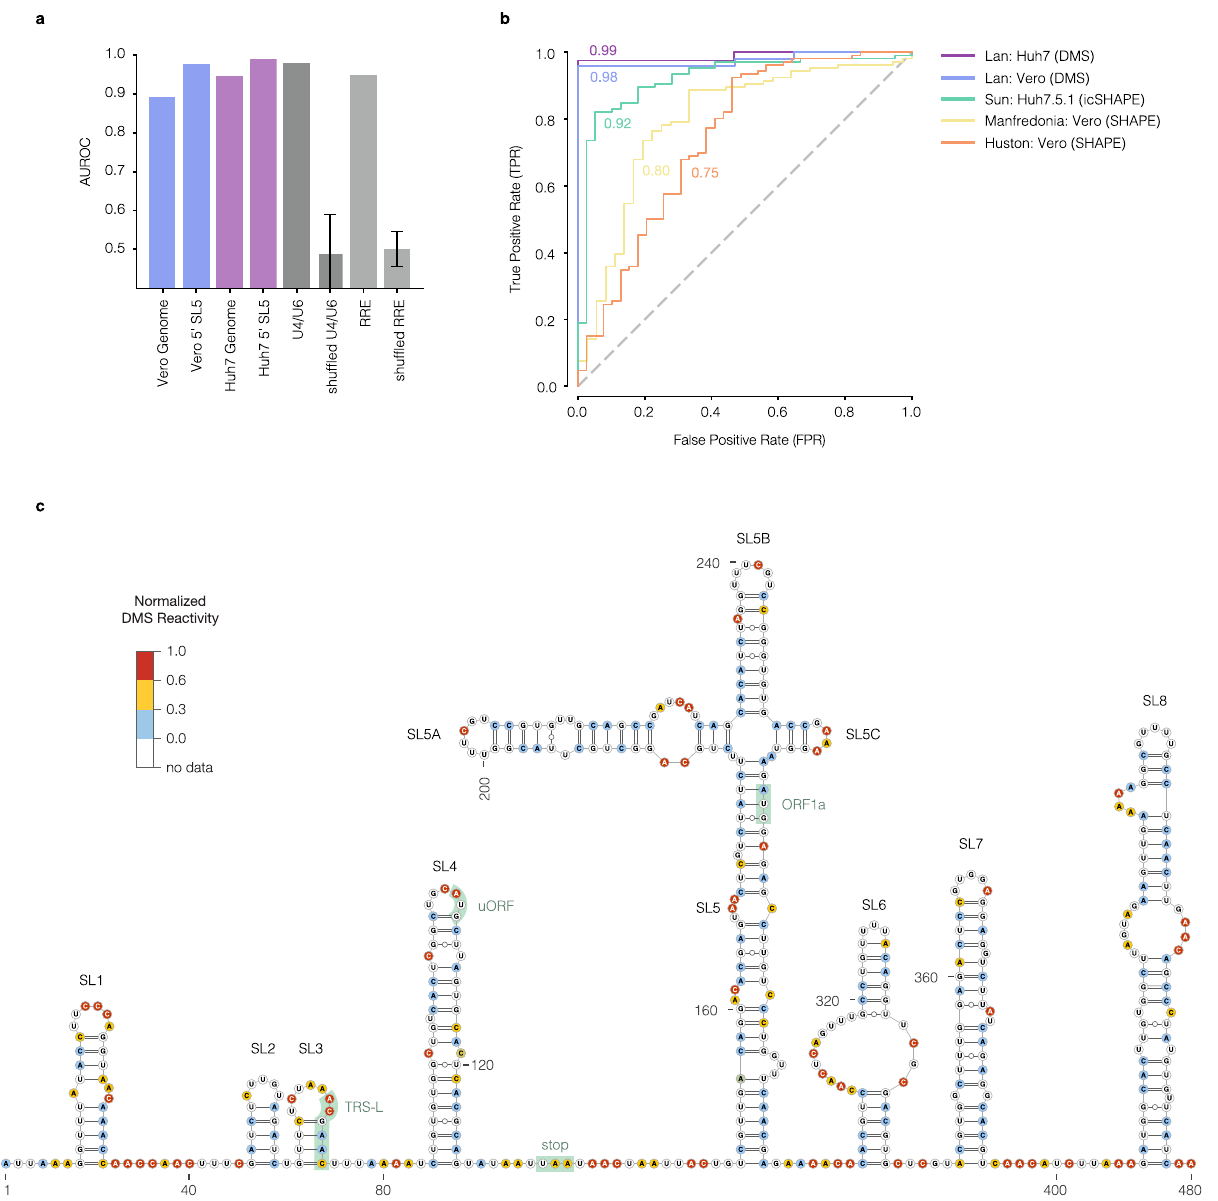
Fig. 2 Quality assessment of the SARS-CoV-2 secondary structure model. a Agreement between DMS reactivities and predicted structures for the Vero and Huh7 genomes, and the consensus structure of 5 ′ untranslated region (UTR) stem – loop 5 (SL5; coordinates 150 – 294), measured as the area under the receiver operating characteristic curve (AUROC). AUROC values between DMS-MaPseq data and well-established structures are also shown for two positive control RNAs: U4/U6 snRNA and HIV-1 Rev Response Element (RRE). As negative controls, n = 100 shuf fl ed datasets were generated by randomly permuting the DMS reactivities and recomputing the AUROC. Data are presented as means ± SD. b Receiver operating characteristic (ROC) curves comparing the literature consensus structure of SARS-CoV-2 SL5 (coordinates 150 – 294) with DMS/SHAPE reactivities from our datasets and those from other authors. Each AUROC value is shown next to its ROC curve. For each dataset, the fi rst author, cell type, and chemical probe are indicated. c Model of the fi rst 480 nt of the SARS-CoV-2 genome (including the 5 ′ UTR, coordinates 1 – 265) based on DMS reactivities from Vero cells. Nucleotides are colored by normalized DMS reactivities. Highlighted features include stem – loops (SL) 1 – 8, the leader TRS (TRS-L), the start codons of the upstream ORF (uORF) and ORF1a, and the stop codon of uORF. Source data are provided as a Source Data fi